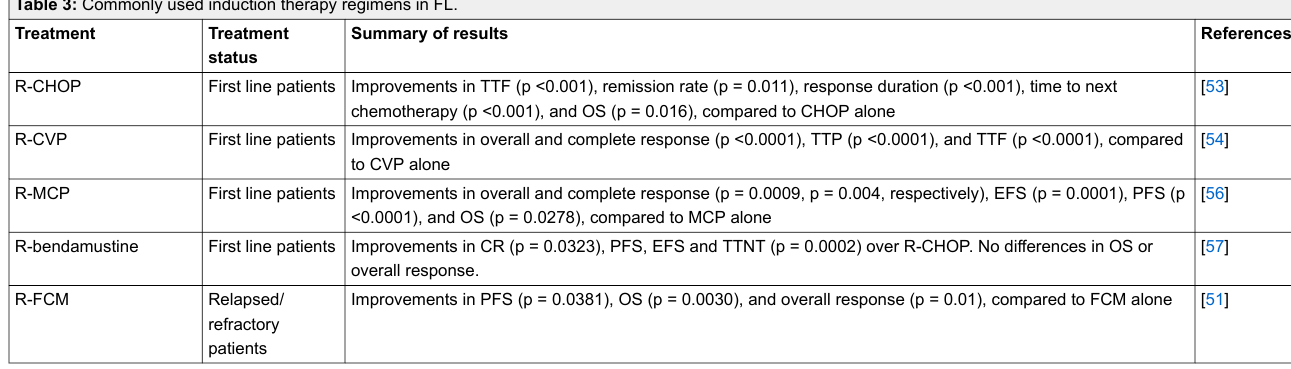
Table 3: Commonly used induction therapy regimens in